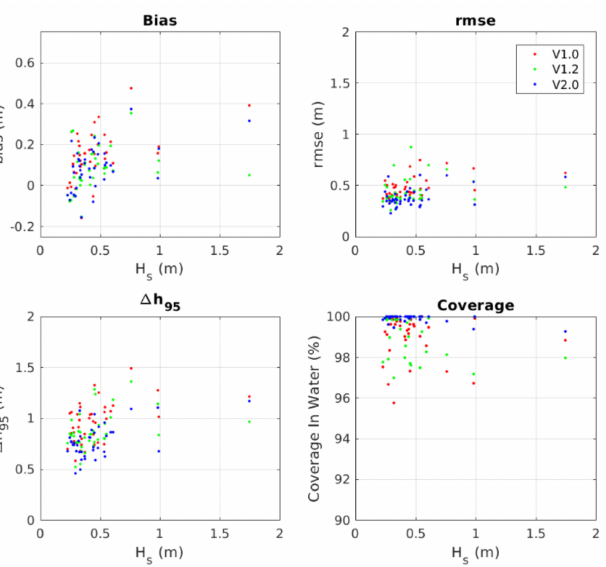
Figure 22. The four performance statistics describing the results from the 39 Kalman results. Version colors are shown in the